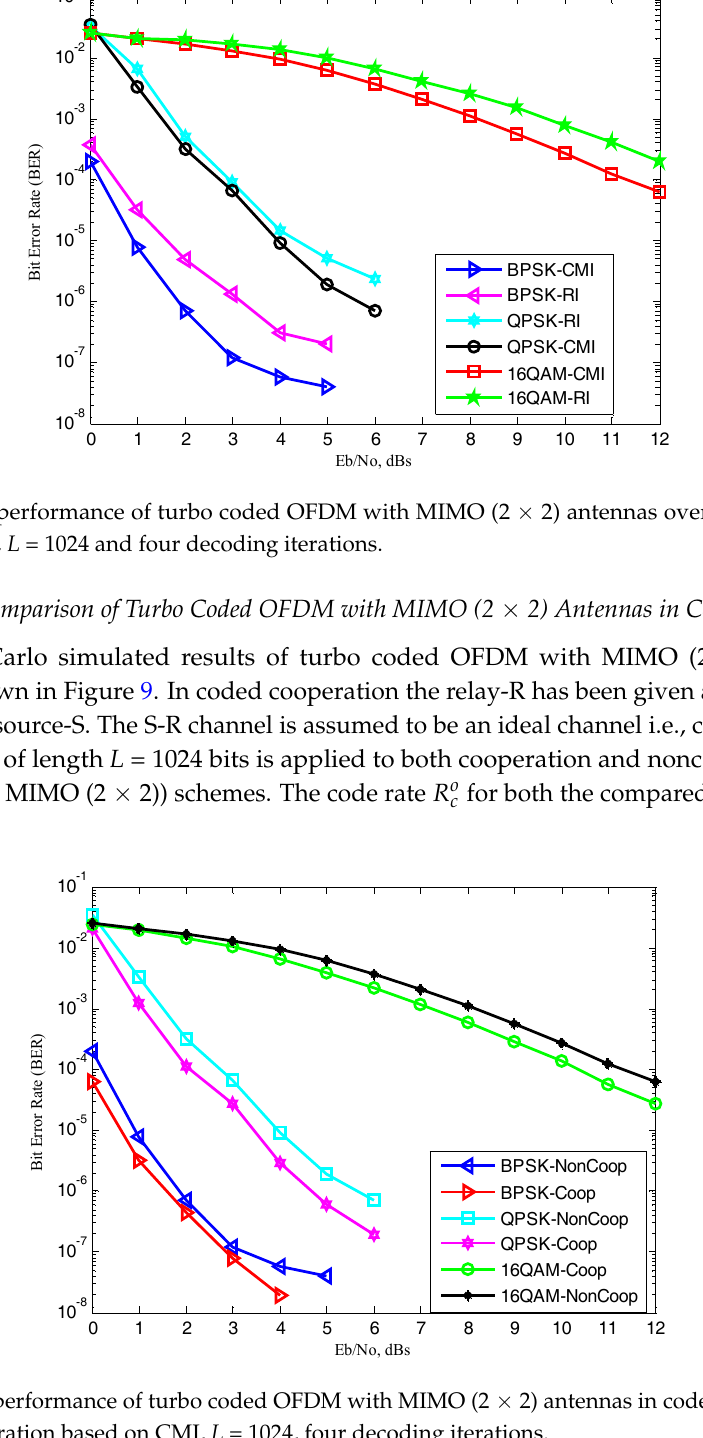
13 of 16 Figure 7 . BER performance of turbo coded OFDM in AWGN channel, L = 256 and four decoding iterations. 6.2. Performance Comparison between CMI and RI for Turbo Coded OFDM with MIMO(2 × 2) Antennas in Fast Rayliegh Fading Channels The performance CMI is also analyzed and evaluated under turbo coded OFDM in MIMO antennas scheme over fast Rayleigh fading channels. The said scheme incorporates two transmit antennas at the source-S terminal and two receive antennas at the destination-D terminal. The interleaver size L is taken as 1024 bits. The decoding iteration is taken as four in all the simulated results. The BER performance of turbo coded OFDM in MIMO antennas scheme with CMI and RI is